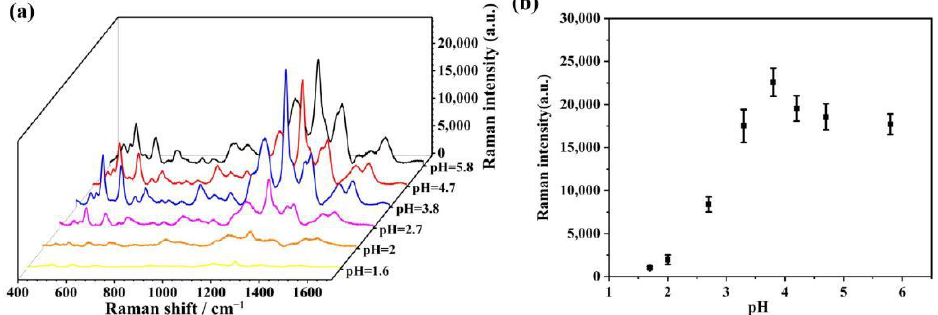
Figure 5. ( a ) SERS spectra of 3.3 × 10 −7 M TBA-MDA adduct with different concentrations of phos- phoric acid as the aggregator ( b ) SERS intensity of 3.3 × 10 −7 M TBA-MDA adduct at 1272 cm −1 as